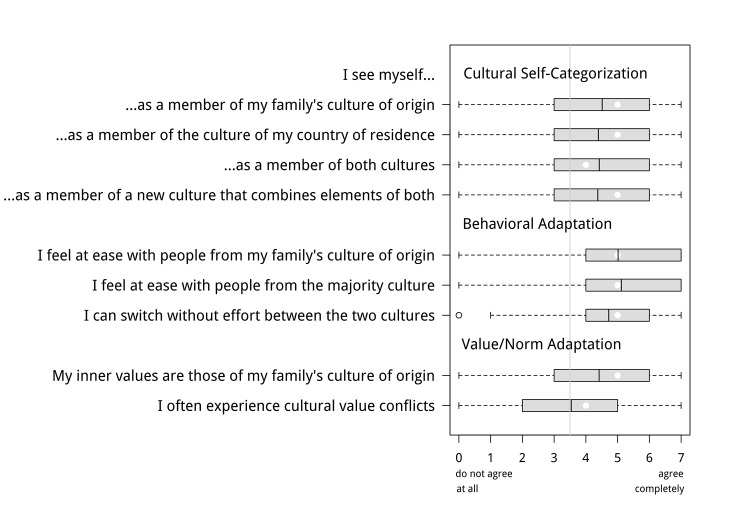
Self-ascribed cultural identity, adaptation on the behavioral level, and on the level of values and norms.Shown are boxplots of the distributions of the corresponding items. The median is represented by a white circle and the mean by a black bar; the box ranges from the first to the third quartile.